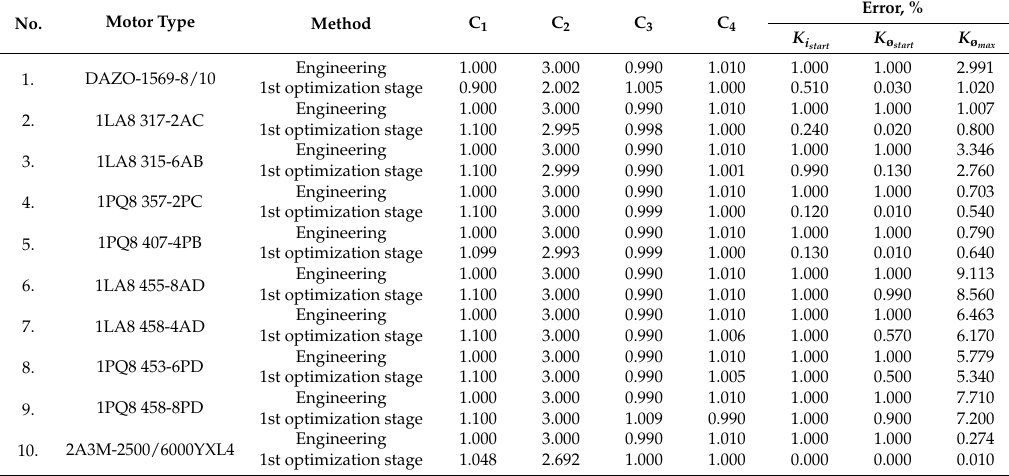
Table 2. Comparison between the Engineering Method and the 1st optimization